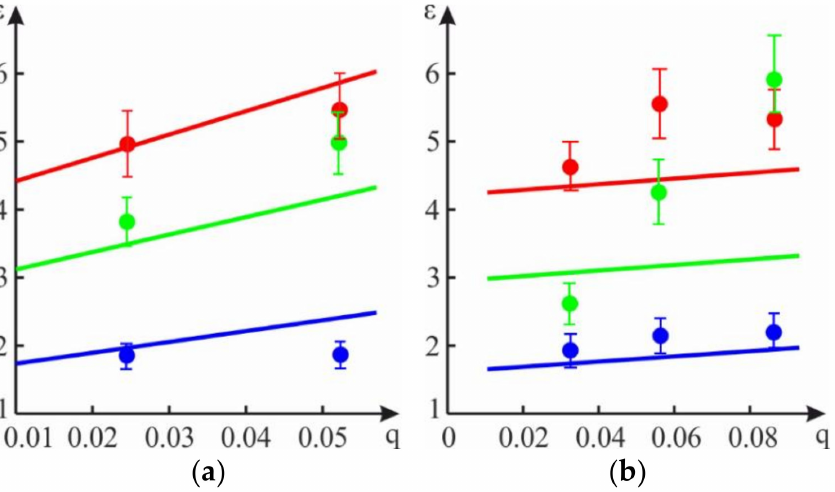
Figure 14. Dielectric constant dependence on the volume part of the filler at different frequencies. Red, 3 MHz; green, 4 GHz; blue, 10 GHz. ( a ) Polymer–Ni samples; ( b ) polymer–Gr samples.